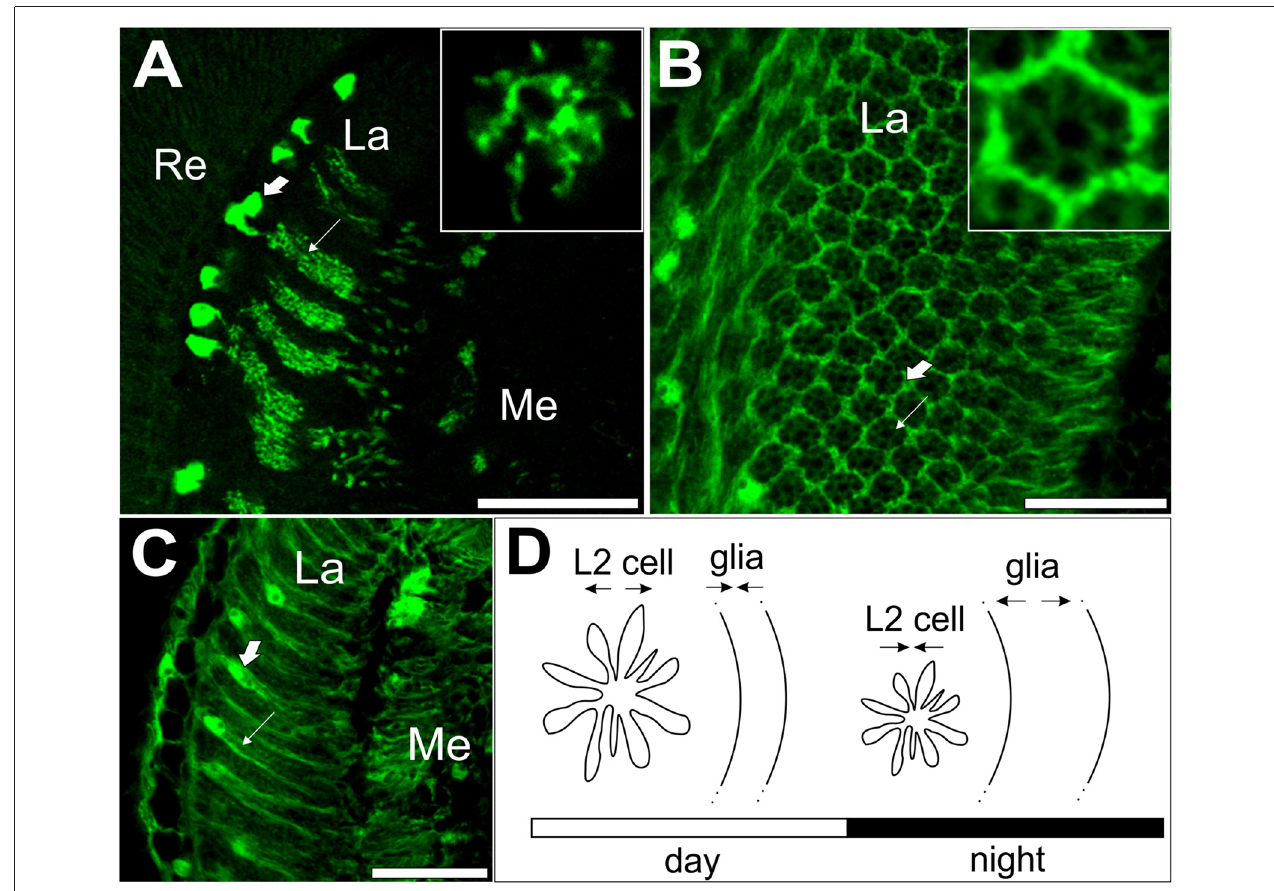
FIGURE 2 | L2 interneurons and glial cells showing circadian plasticity in the visual system of Drosophila melanogaster . (A) GFP-labeled L2 monopolar cells, first order interneurons, in the optic lobe lamina. Large arrow indicates L2 somata; small arrow indicates L2 axons with dendrites. Insert: cross section of an L2 axon with dendrites. (B) Cross section of the lamina with GFP-labeled epithelial glial cells (large arrow) surrounding lamina cartridges (small arrow). Insert: a single cartridge surrounded by three epithelial glial cells. (C) GFP-labeled epithelial glial cells in the lamina. Large arrow indicates the soma; small arrow indicates processes of epithelial glial cells. (D) A schematic representation of circadian plasticity in the L2 dendritic tree and epithelial glial cells. Changes in neuron size are offset by changes in glia size. Re, retina, La, lamina, Me, medulla of the optic lobe. Scale bar: 20 µ m (Pyza and Górska-Andrzejak, 2004; Weber et al.,